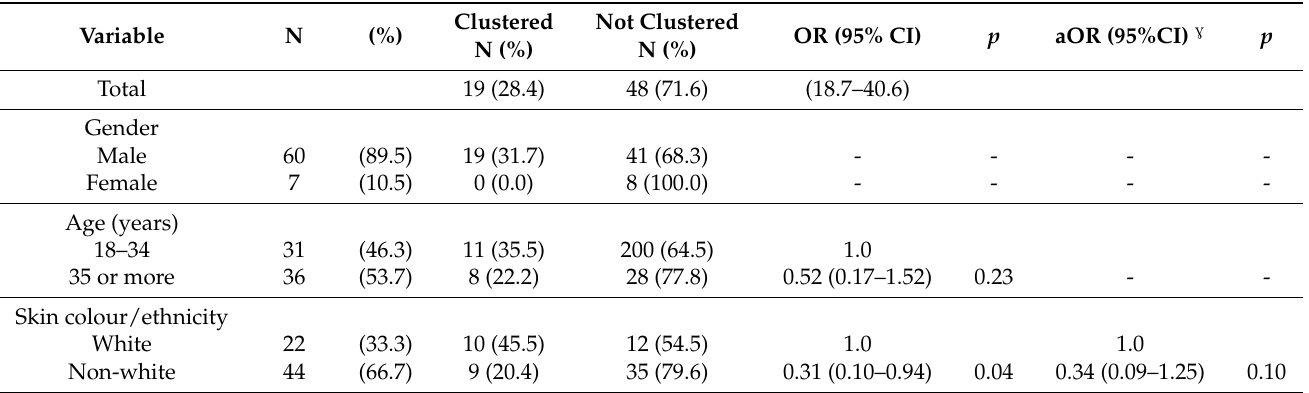
Table 2. Sociodemographic and behavioral characteristics of HIV-infected prison inmates according to clustering (n = 84), Central